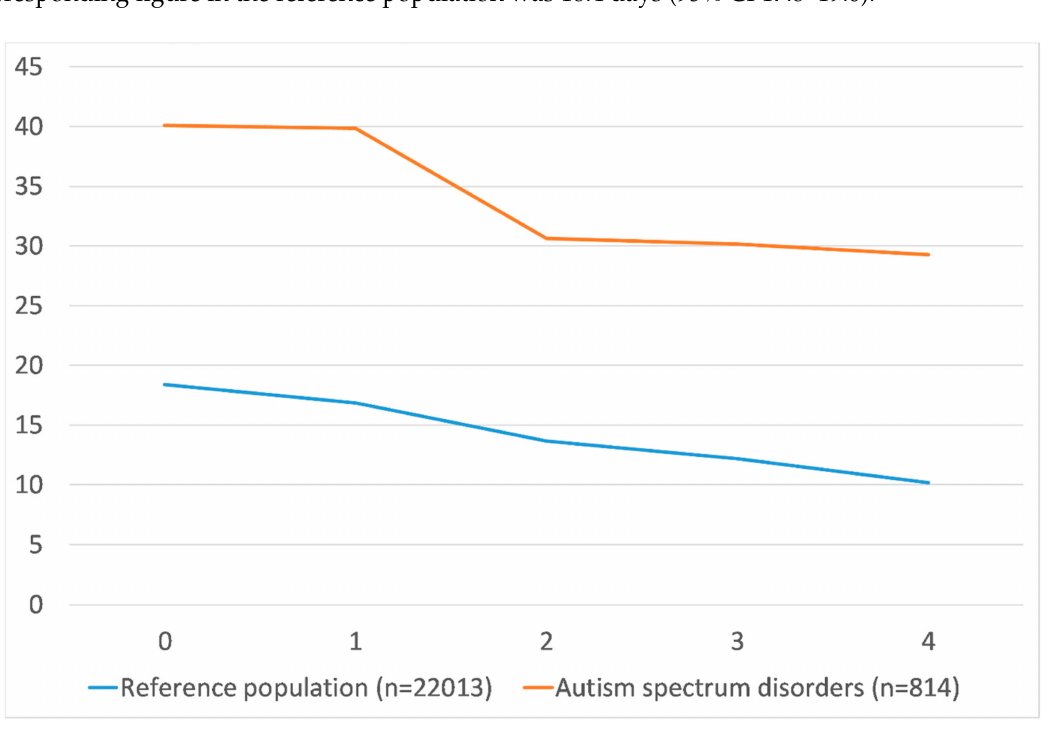
Figure 3. Mean unemployment days ( y -axis) during the cohort entry year and four years after ( x -axis), among people with autism spectrum disorder (ASD) and in their matched references from the general